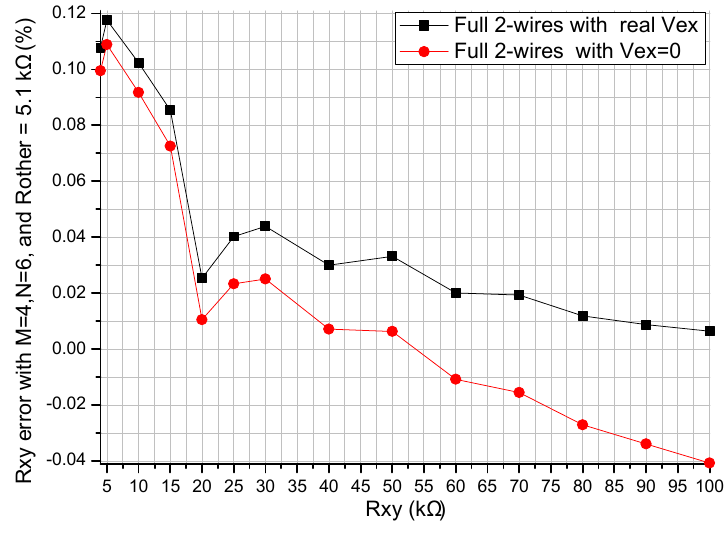
Figure 8. V ex effect on the EBT’s error in the full two ‐ wire prototype circuit.